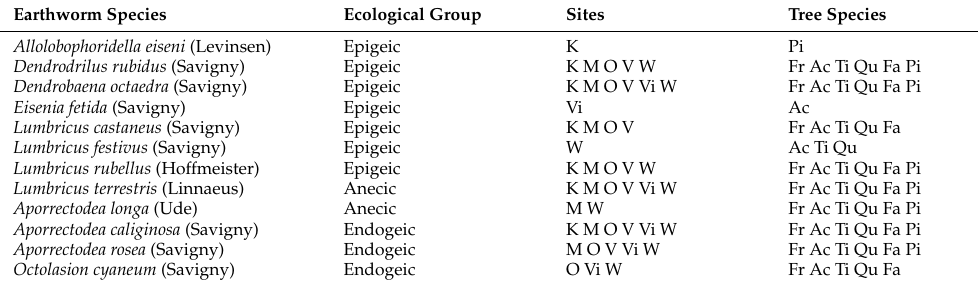
Table 3. Collected earthworm species, their ecological group according to Sims and Gerard [15], their incidence at the studied sites (K = Kragelund, M = Mattrup, O = Odsherred, V = Vallø, Vi = Viemose, W = Wedellsborg) and tree species (Fr = Fraxinus , Ac = Acer , Ti = Tilia , Qu = Quercus , Fa = Fagus , Pi = Picea